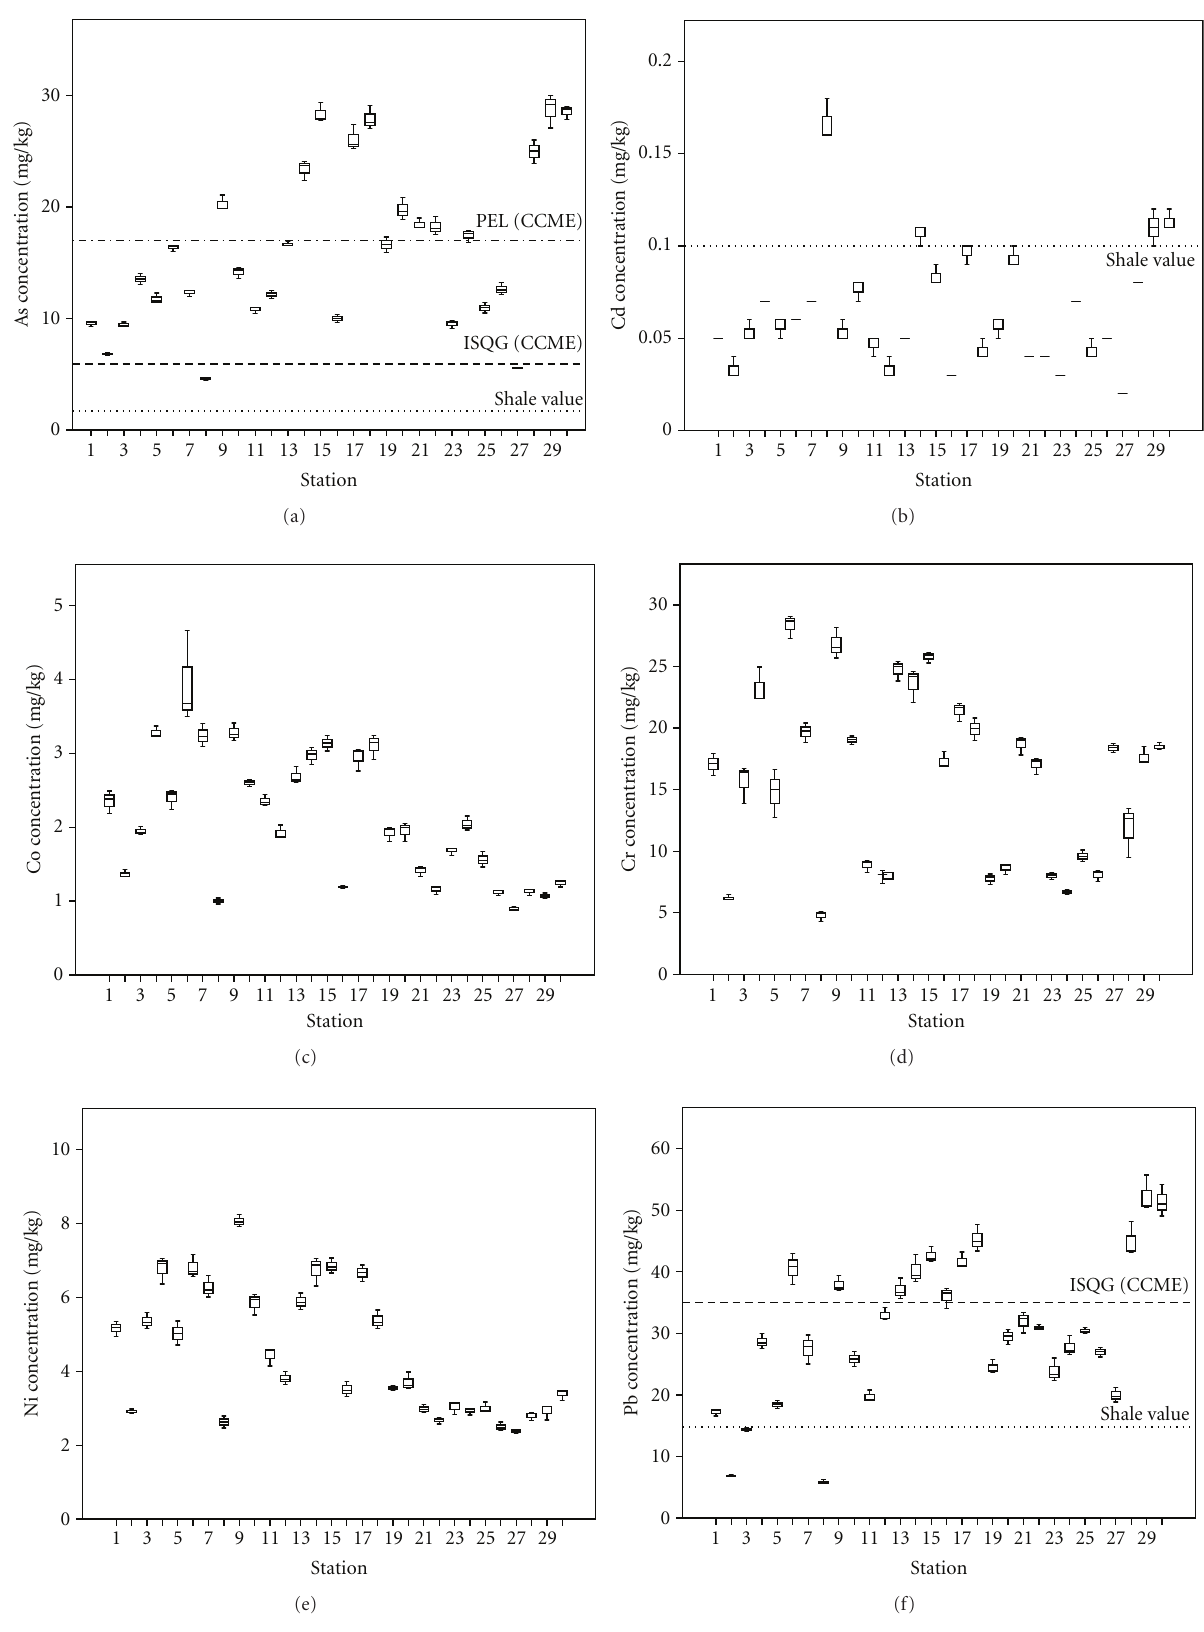
Figure 6: Distribution of each heavy metal concentration (mg/kg) along stations in Langat River sediments by comparing with average shale value and ISQG